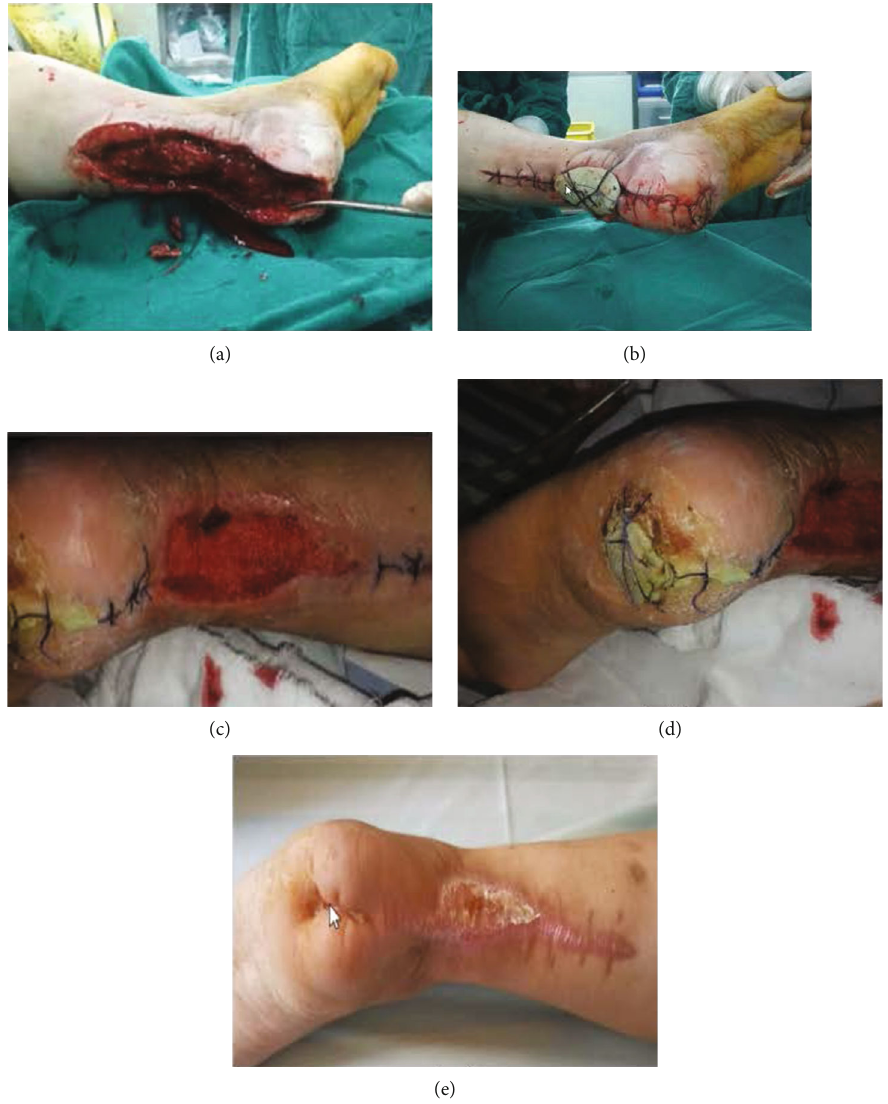
Figure 4: Diabetic heel ulceration. Diabetic heel ulceration (a) during surgery, (b) immediately after surgery, (c, d) 3 weeks after surgery, and (e) 12 weeks after